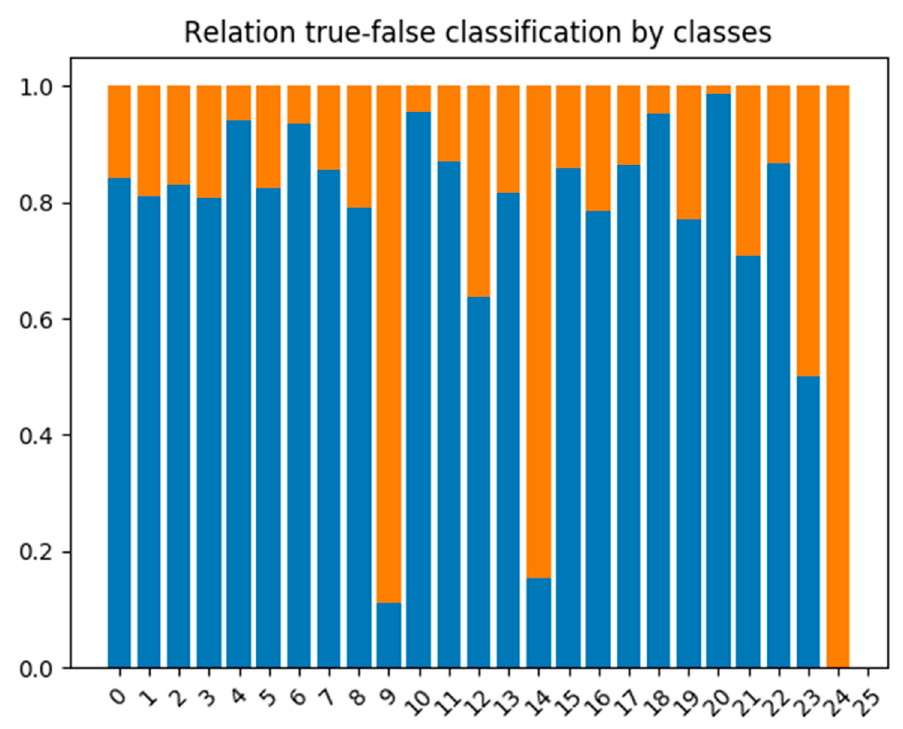
Figure 6. Classification accuracy for 26 whales.